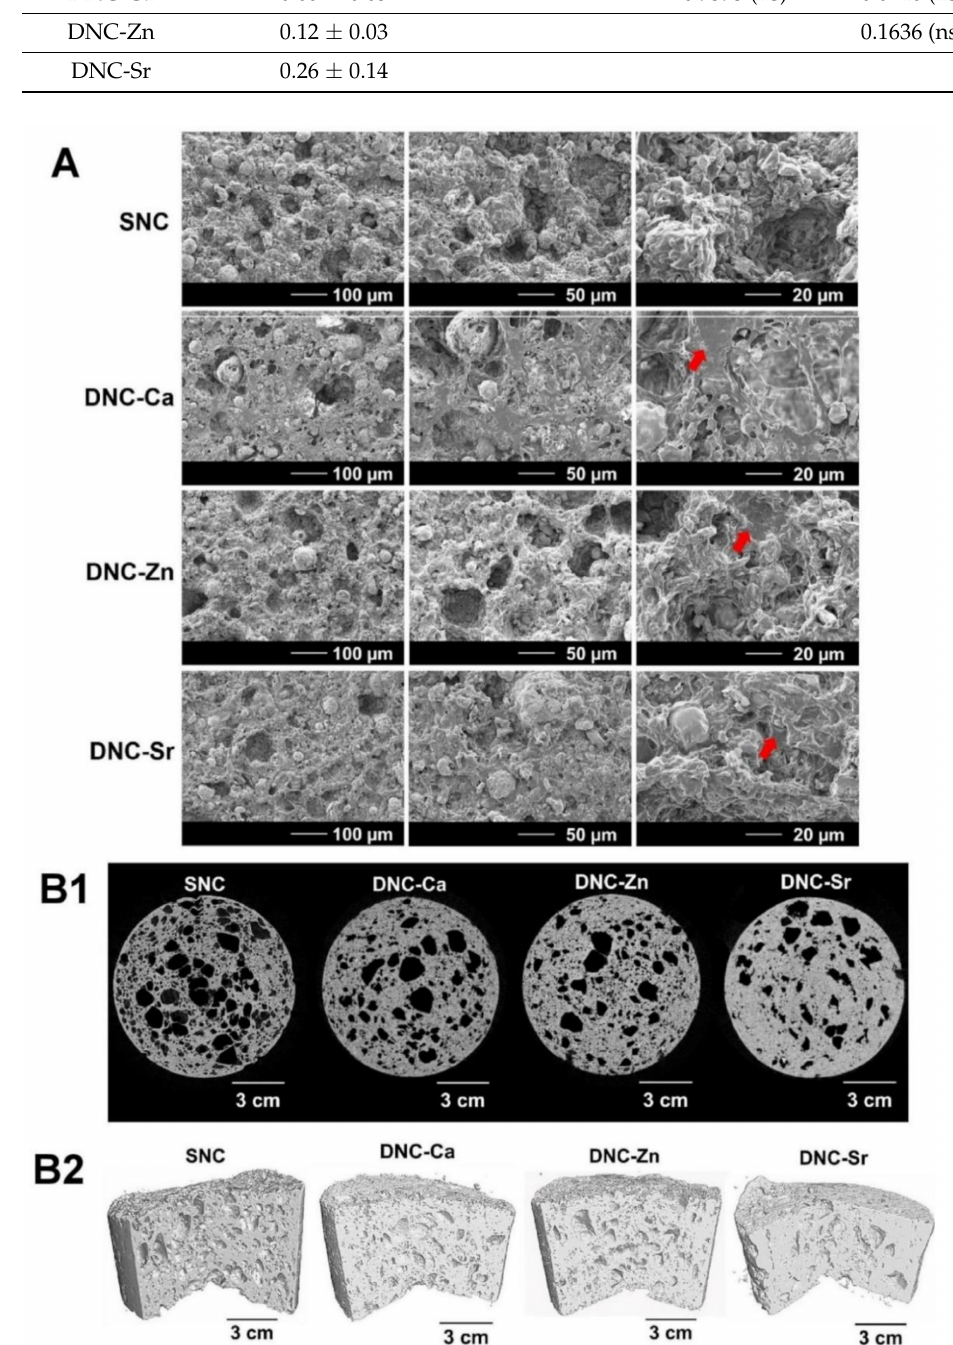
Figure 4. Morphological characterisation of the dual network composites chelated with Ca 2+ (DNC- Ca), Zn 2+ (DNC-Zn) and Sr 2+ (DNC-Sr) compared with the single network composite (SNC): ( A ) scan- ning electron micrographs in the dry state. Smears of polymeric network are visible in the DNC’s (indicated by red arrows), likely to be the alginate network; ( B1 ) micro-computed tomography ( µ CT) at cross-sectional and ( B2 ) sagittal plane in the hydrated